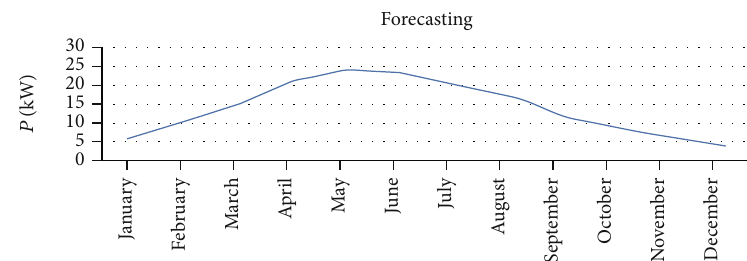
Figure 13: Power forecasted by the BIPV system for 2013, based on the estimation of multiannual solar radiation.